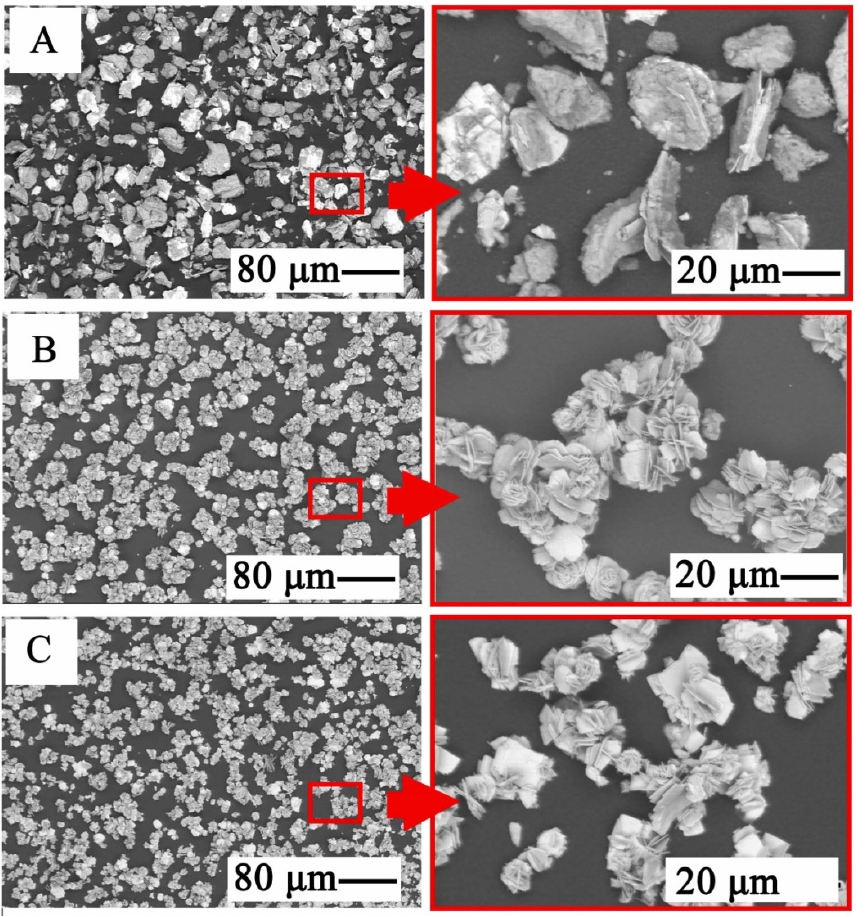
Figure 26. SEM image of the phases precipitated during selective alkalization and zinc precipitation with Na 3 PO 4 for: ( A ): pH = 4.0, ( B ): pH = 4.5, ( C ): pH = 6.5 .